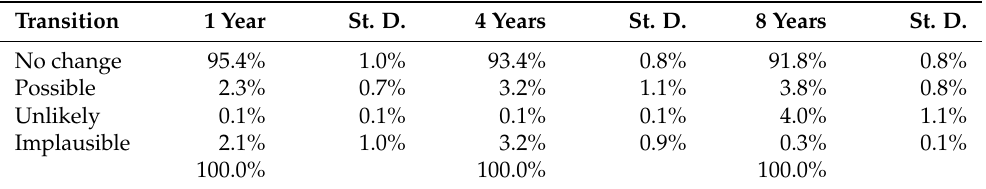
Table 6. Summary statistics for one, four and eight-year transitions of CNN model results